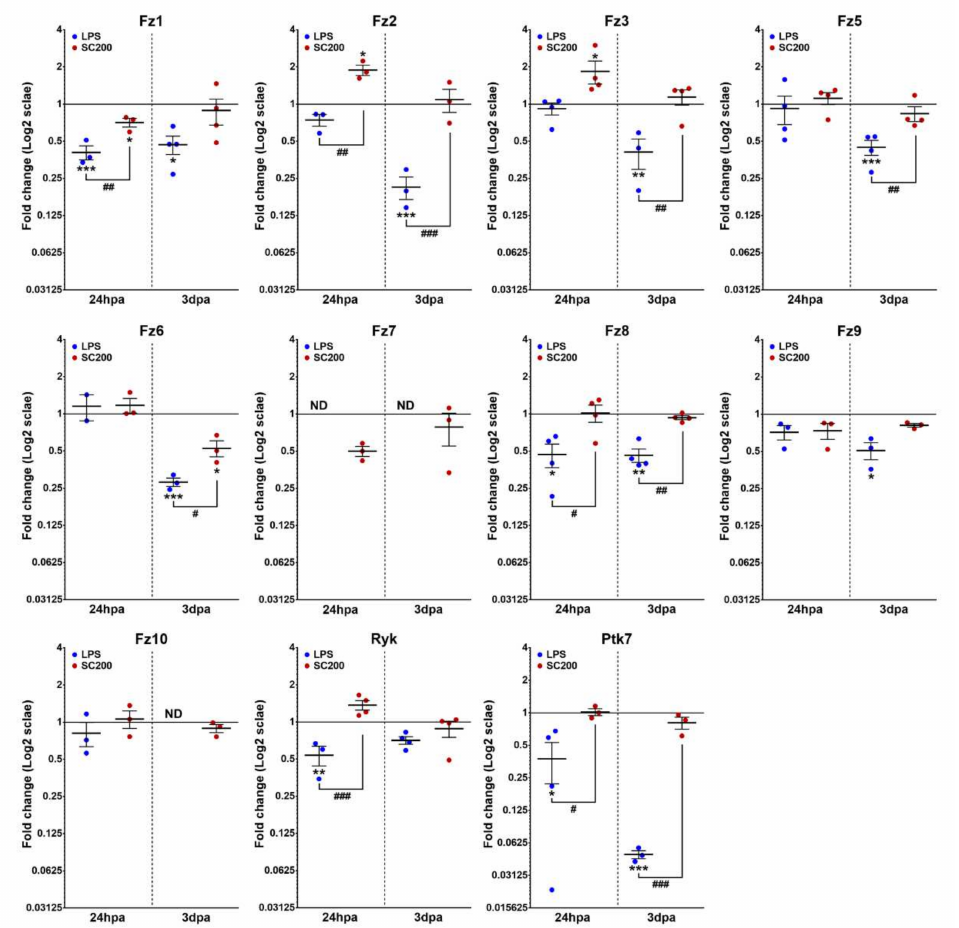
Figure 3. mRNA expression analysis of Wnt receptors in LPS- or SCE-activated microglia and com- pared to non-activated basal conditions. The figure shows mRNA expression data corresponding to different detectable receptors in activated microglial cells either with 100 ng/mL of lipopolysaccharide (LPS) or with 200 µ g/mL of lesioned spinal cord extract (SCE). Data represent 2 ∆∆ Ct mean ± SEM. * indicate differences between treated cells vs. non-activated. # indicate differences between treat- ments (LPS vs. SCE). * p < 0.05; ** p < 0.01; *** p < 0.001; # p < 0.05; ## p < 0.01; ### p < 0.001. hpa: hours post-activation; dpa: days